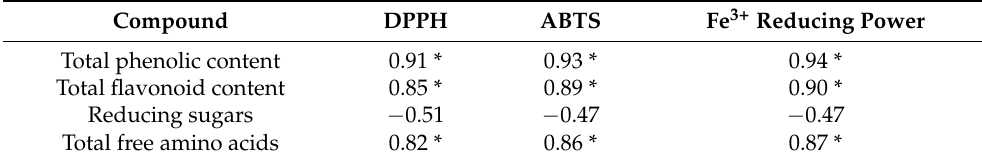
Table 2. Pearson correlation analysis between DPPH, ABTS and Fe 3+ reducing power and total phenolic content, total flavonoid content, reducing sugars and total free amino acids of three Centaurea